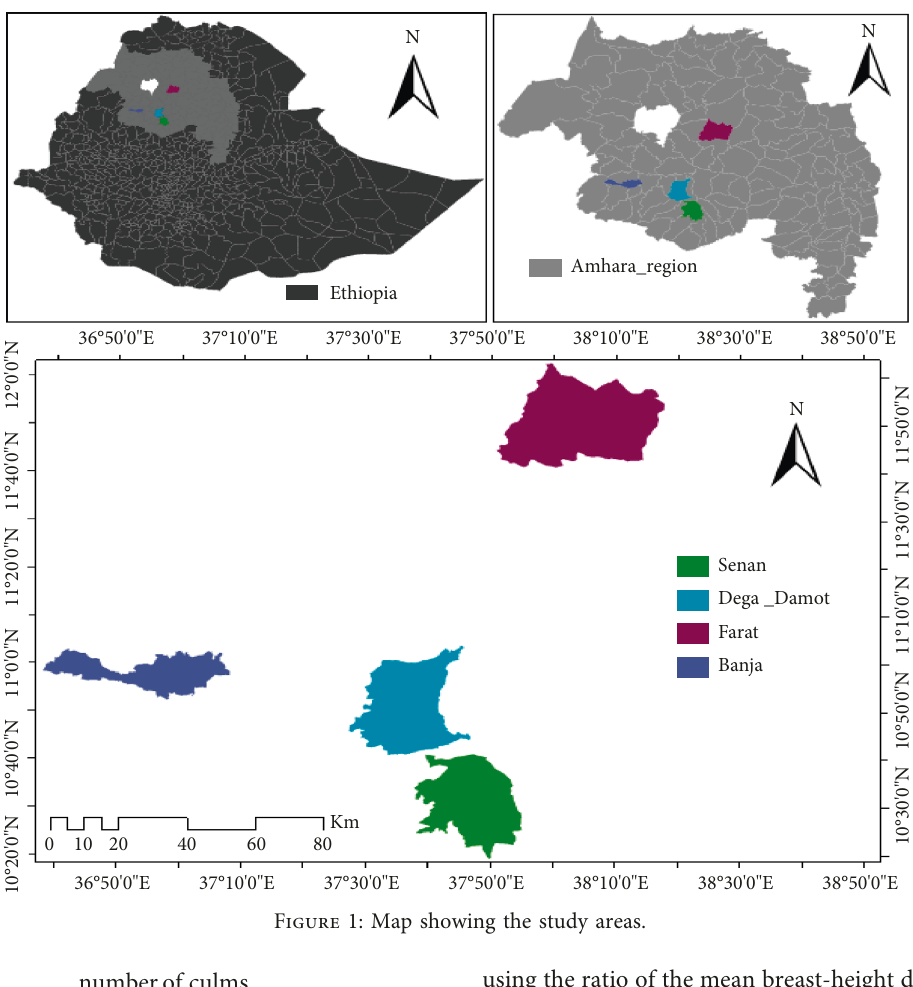
Figure 1: Map showing the study